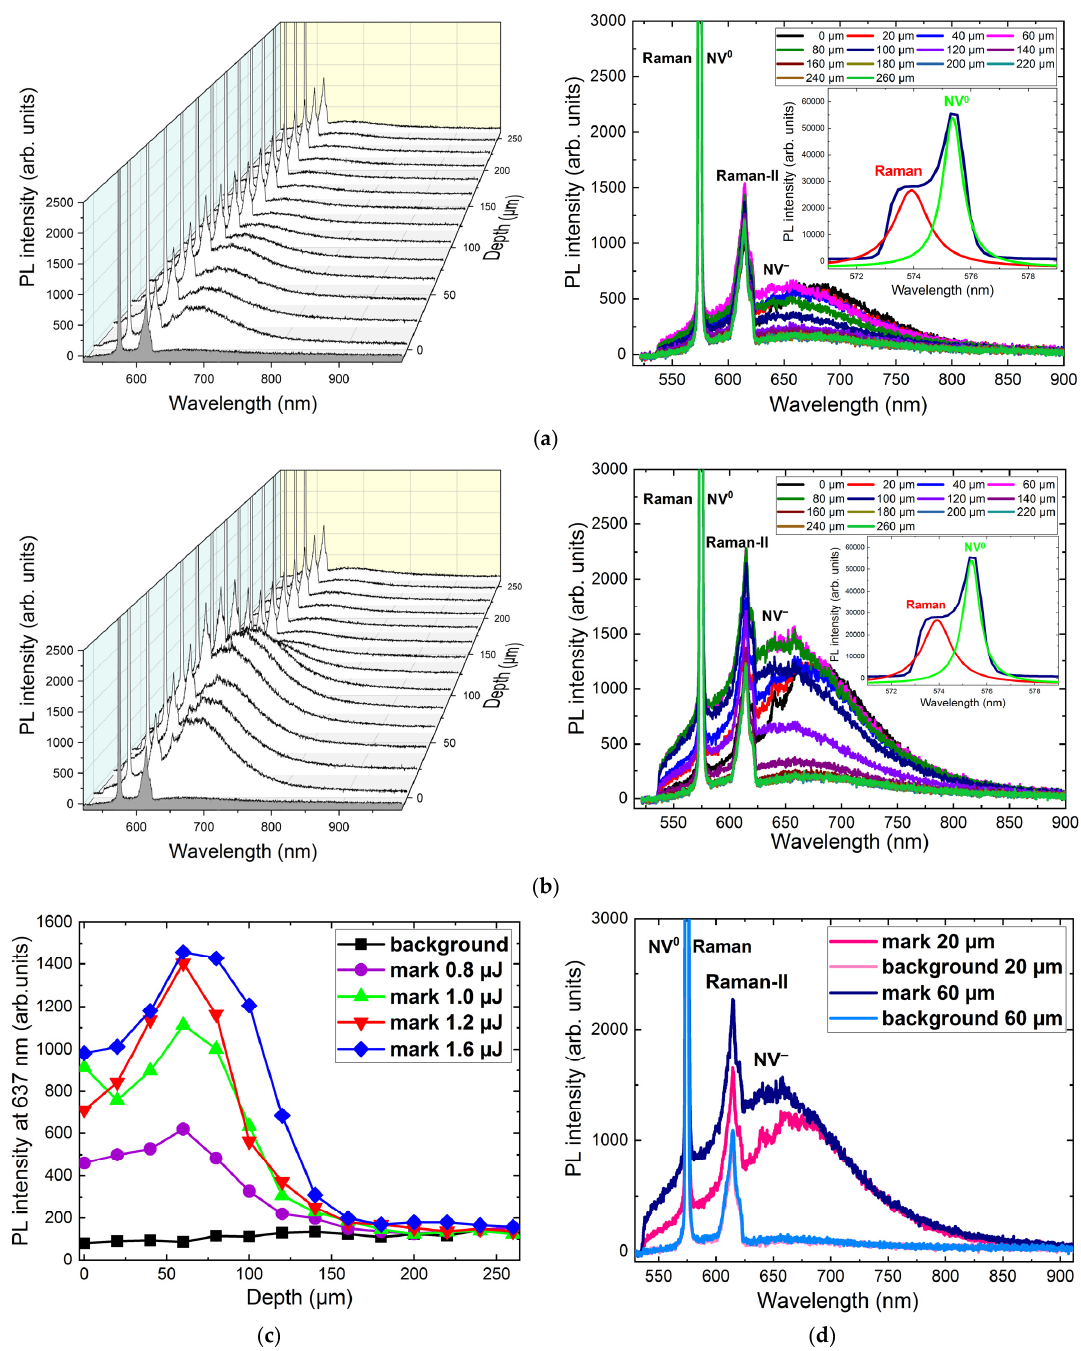
Figure 3. The 532 nm excitation PL spectra at different depths inside the sample for different pulse energies: 0.8 µ J ( a ), 1.6 µ J; ( b ) (spectral assignment after; grey color indicates initial spectra of the diamond, τ = 0.3 ps, exposure for 240 s (24M pulses)); ( c ) intensity at NV − band (~637 nm) versus depth; ( d ) 532 nm PL spectra of the background (initial diamond) and micromarks (irradiated diamond) at different depths (20 and 60 µ m) (irradiation: 240 s exposure time (24M pulses), 0.3 ps, laser pulse energy—1.6 µ J; spectral assignment